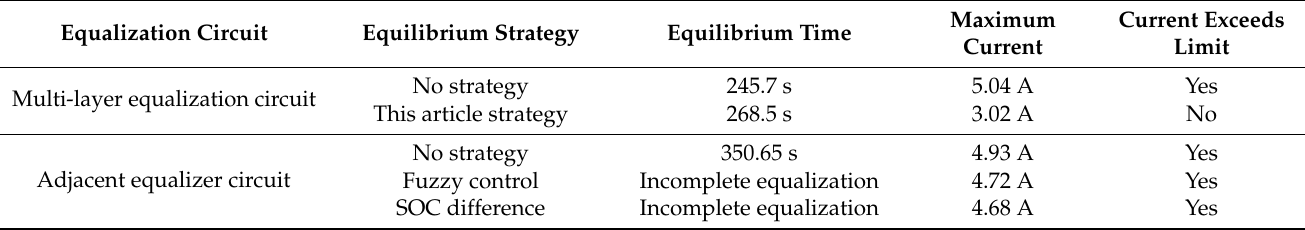
Table 5. Comparison of equilibrium results.